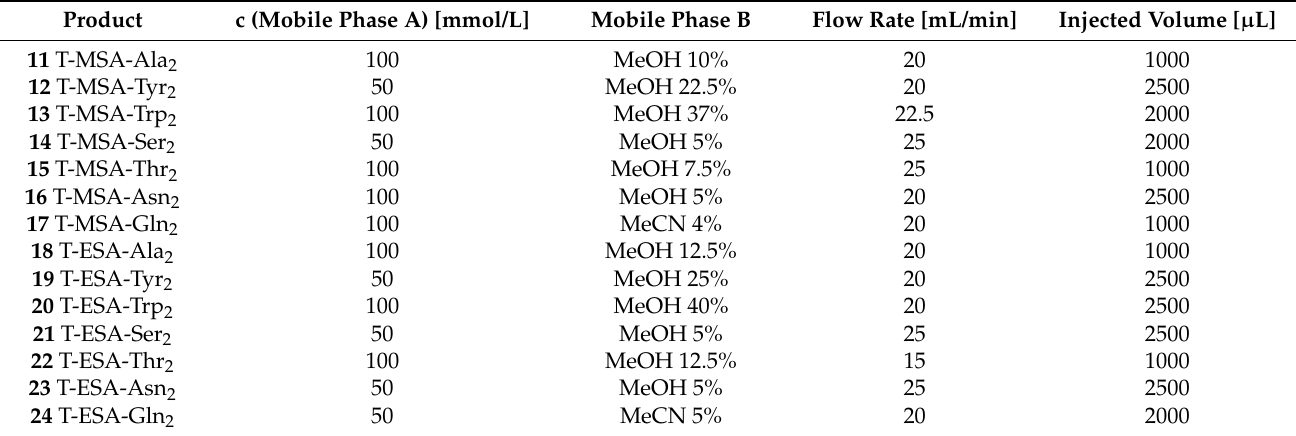
Table 3. Summary of optimized chromatographic conditions used for the purification of products 11 – 24 by semi-preparative LC with RP-C18 stationary